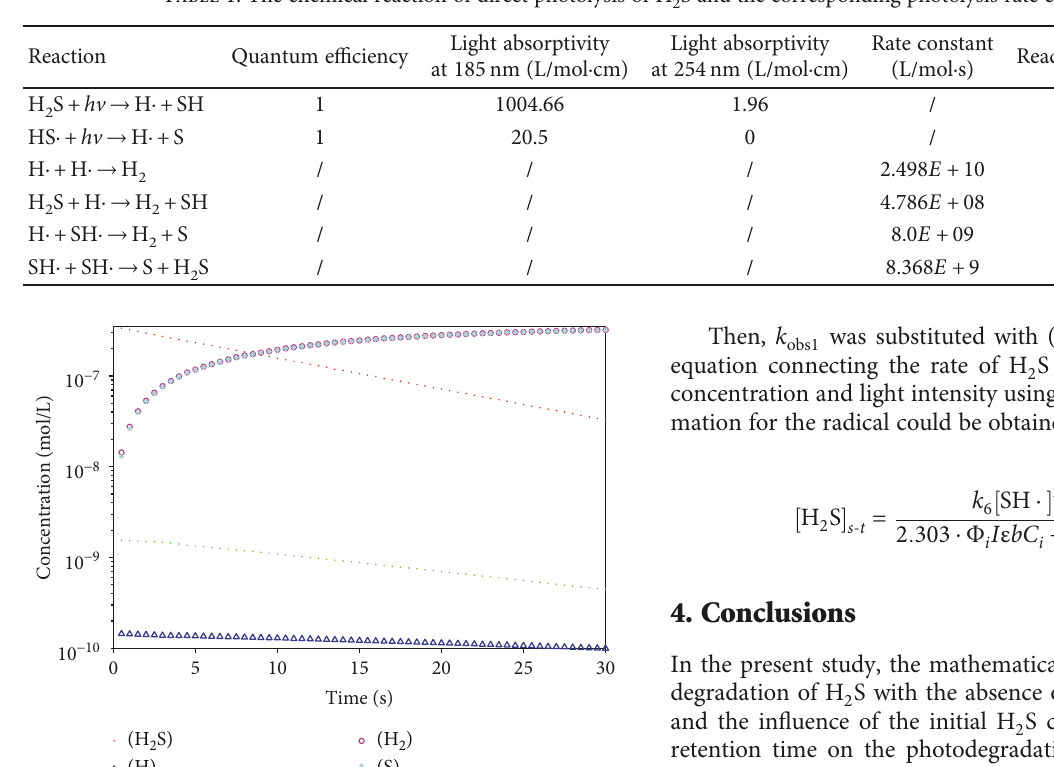
S and the corresponding photolysis rate constants. 2